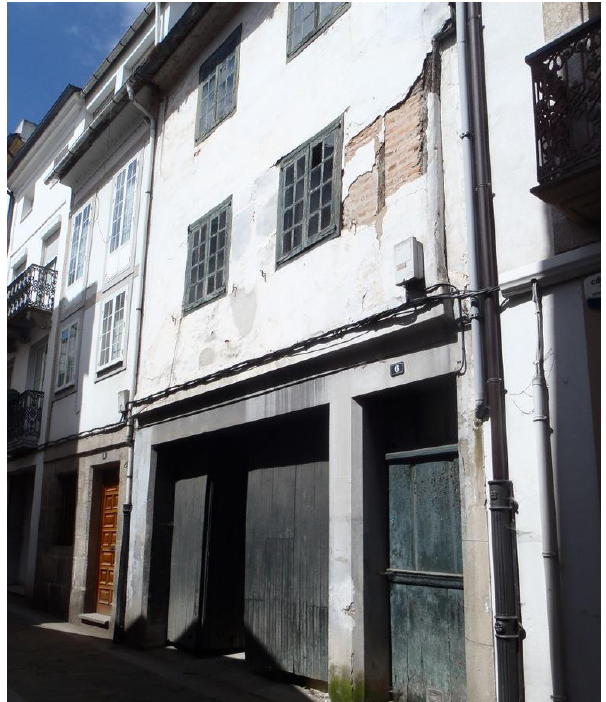
Figure 18. Half-timbered with brick house with a modified ground floor in Guevara street. Source: